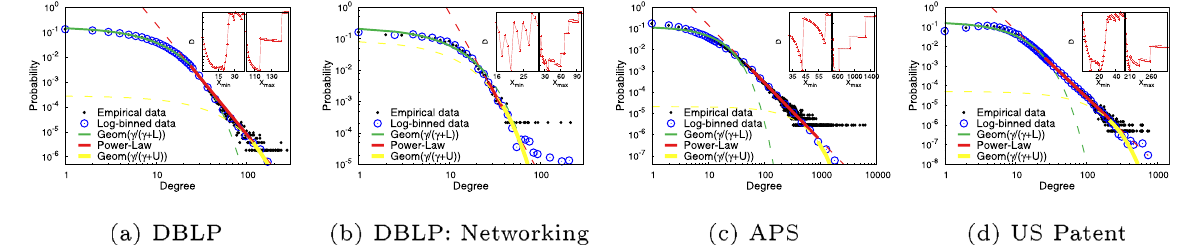
Figure 3. Citation probability versus the number of citations on a double logarithmic scale using partial logarithmic binning 57 . The inner figures show the values of Kormogorov-Smirnov test vs. X min and X max .  and  are selected from X min and X max to minimize the KS-test distance value. The detail of the fitting method is presented in the Sec. S9 of SI.